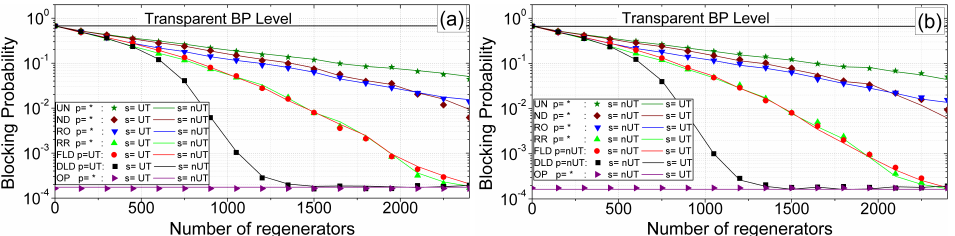
Figure 2. Blocking probability as a function of the total number of regenerators in CoreNet topology under 600erlangs load and: ( a ) uniform and ( b ) non-uniform